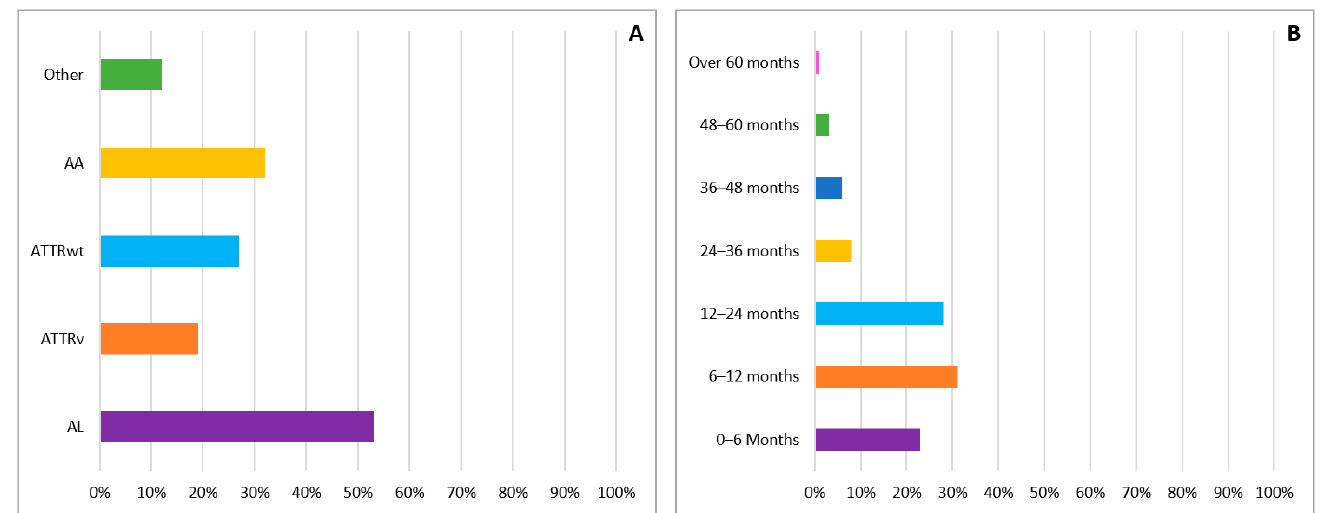
Figure 2. ( A ) Most frequently seen etiologies of cardiac amyloidosis in the clinical practice of the surveyed cardiologists. ( B ) Mean delay from the first presentation with cardiac symptoms to diagnosis of cardiac amyloidosis reported by the surveyed cardiologists.